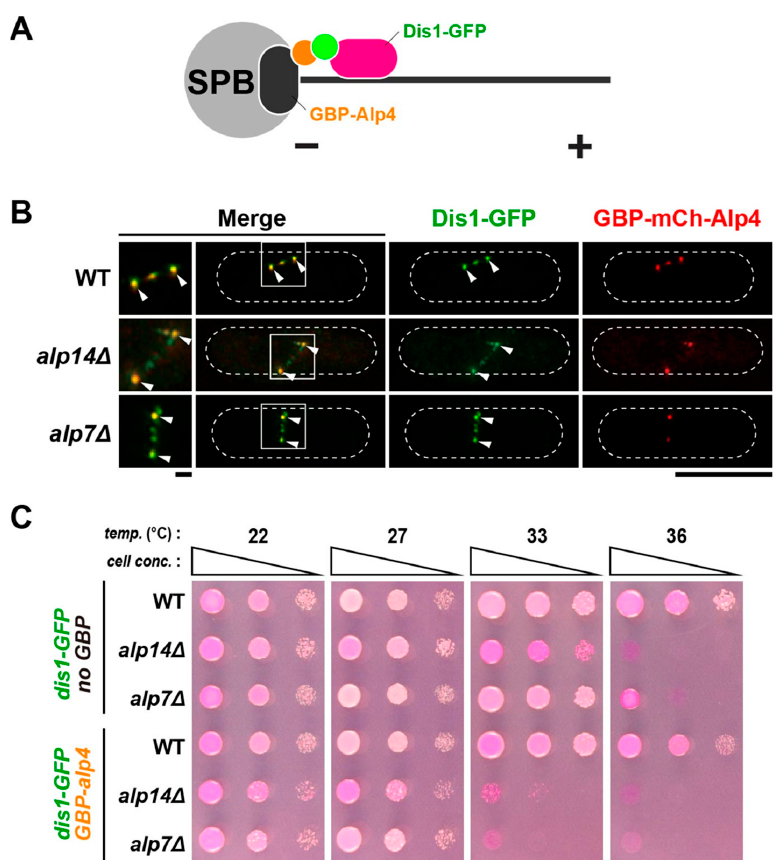
Figure 5. SPB-tethered Dis1 is incapable of rescuing alp14 ∆ . ( A ) A schematic illustration of a strategy for tethering Dis1 to the SPB. ( B ) Visualisation of Dis1-GFP localisation in strains containing GBP-mCherry-Alp4. Cell peripheries are indicated with dotted lines and areas containing spindle MTs (squares) are enlarged in the left-hand side panels. Note that in addition to SPB localisation (arrowheads), some fractions of Dis1-GFP are localised to additional dots between the two SPBs. This location is most likely to be the kinetochore, to which Dis1 is normally localised during mitosis [15,20,37]. Scale bars, 1 µ m (left) and 10 µ m (right). ( C ) Spot test. Indicated strains were serially (10-fold) diluted, spotted onto rich YE5S plates containing Phloxine B and incubated at the indicated temperatures for 2-3 d.